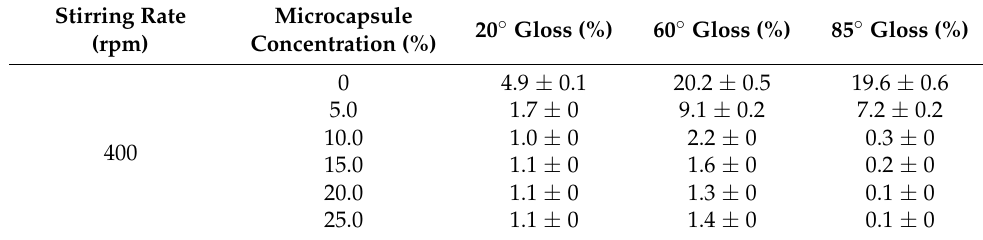
Table 2. Effect of microcapsule concentration with different stirring rates on gloss of waterborne